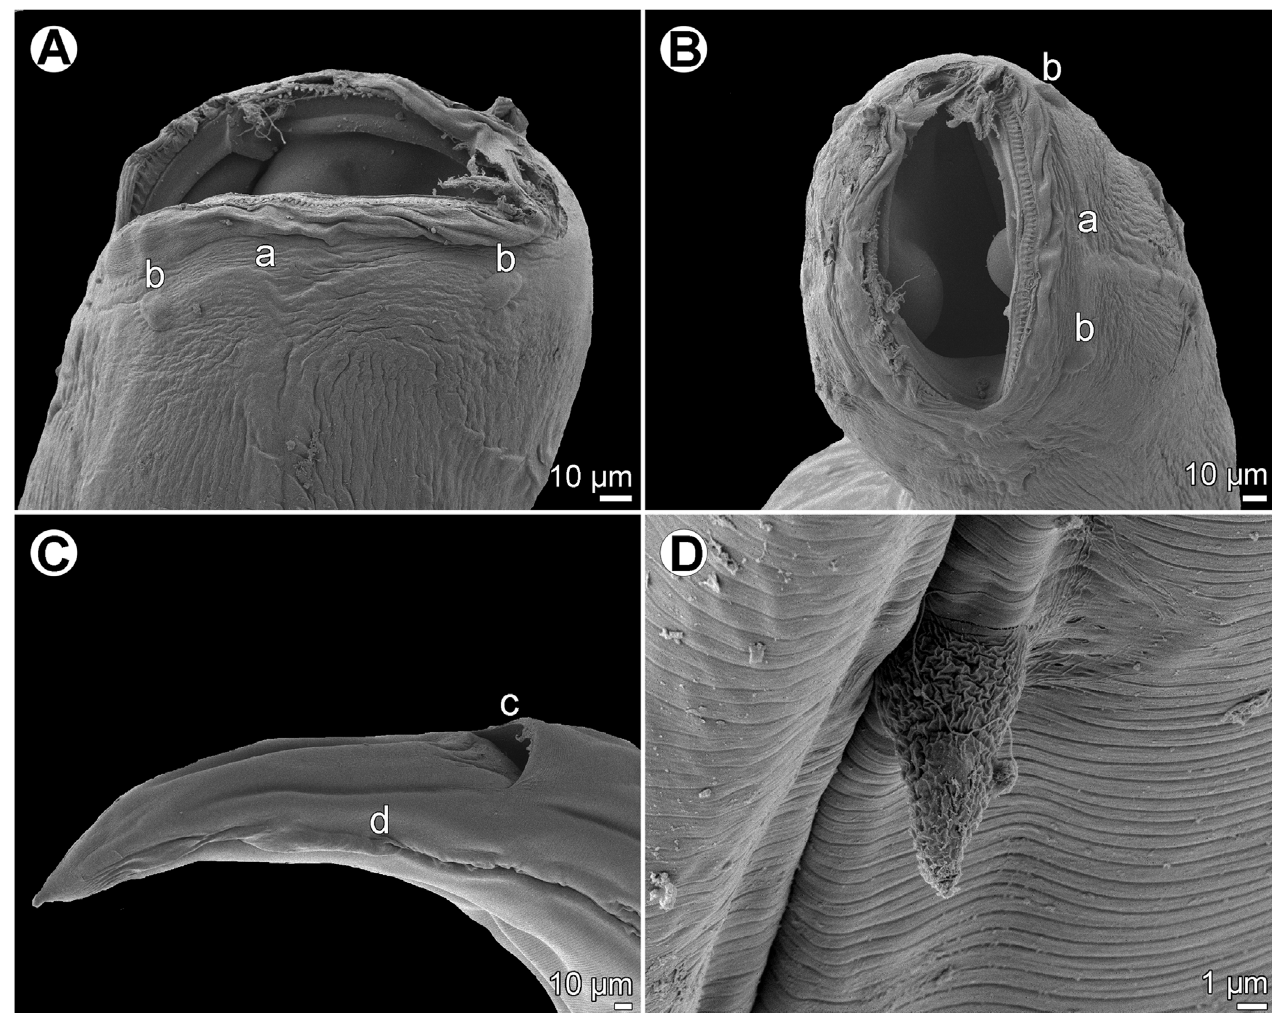
Figure 3. Cucullanus variolae n. sp., scanning electron micrographs of female from V . albimarginata . (A, B) Cephalic end, lateral and apical views, respectively; (C) tail of juvenile specimen, lateral view; (D) deirid. (a) Amphid; (b) cephalic papilla; (c) anus; (d)